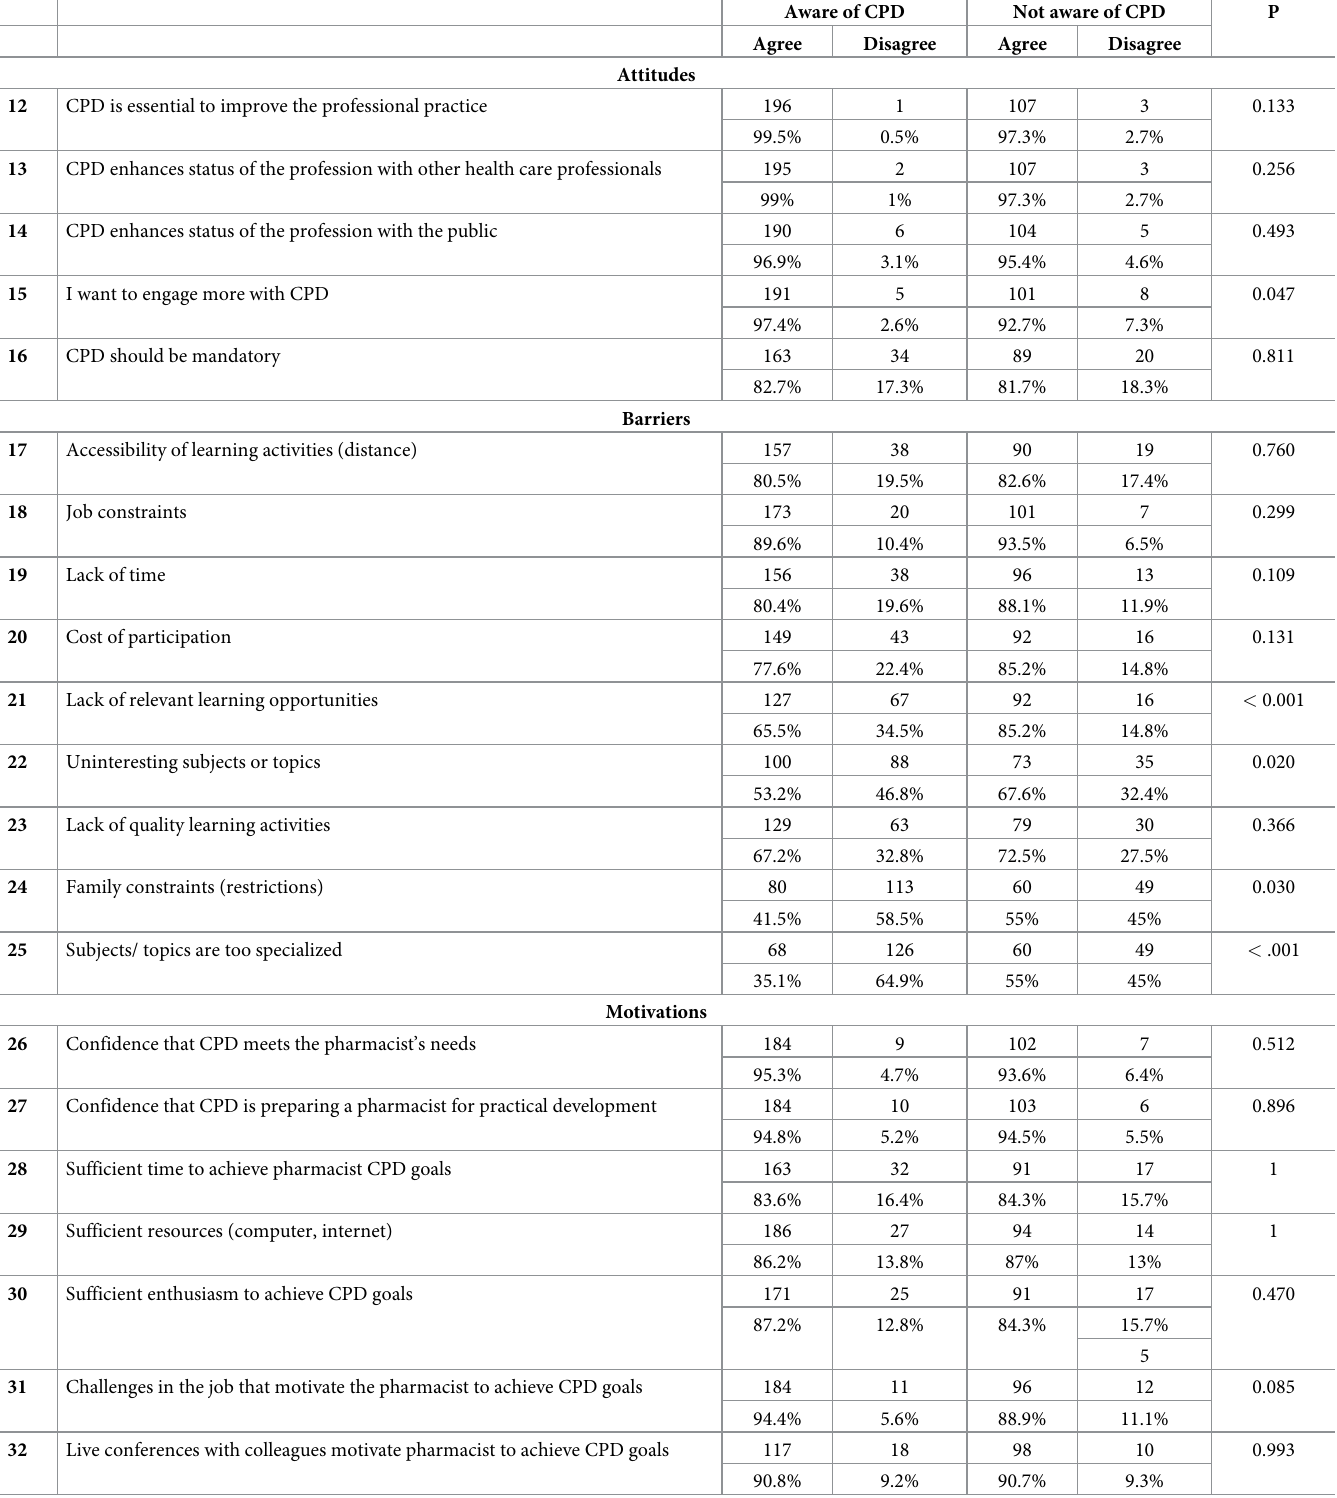
Table 2. Comparison of percentages and frequencies of agree/disagree to different statements for attitudes, barriers, and motivation between those participants who are aware about CPD and those who are